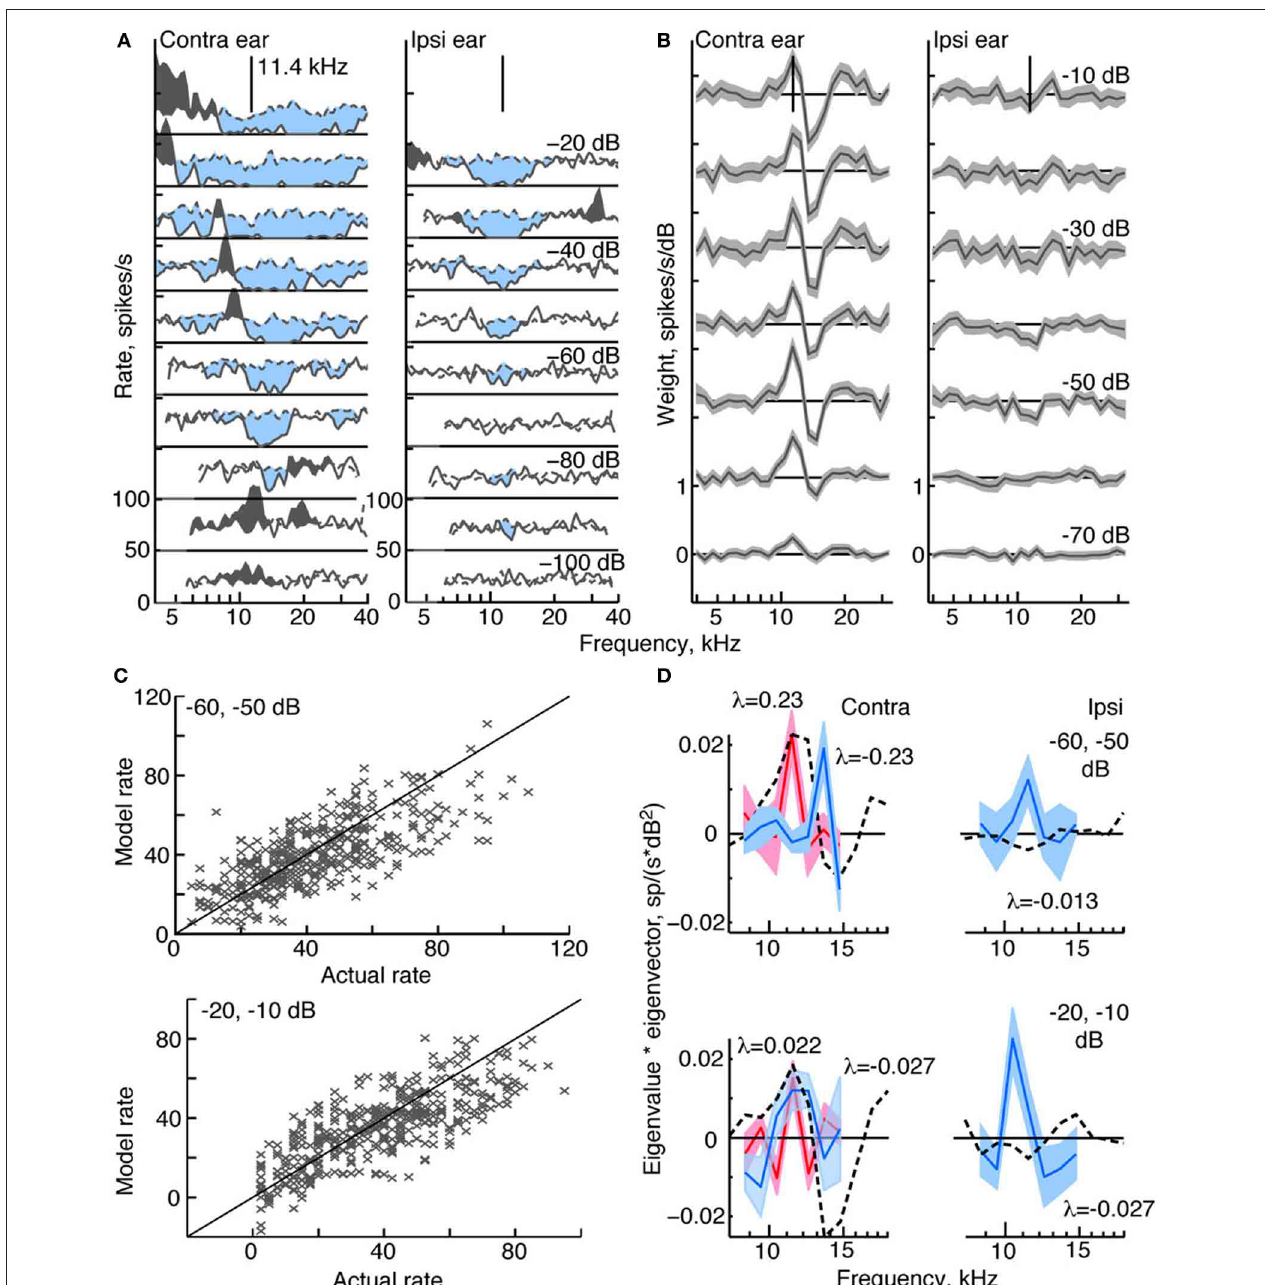
FIGURE 3 | Response characteristics for a type O neuron, BF 11.4kHz. (A,B) Tone response maps and RSS weight functions, plotted as in Figure 2 . Note the large inhibitory area centered on BF in the contralateral and ipsilateral tone response maps. Also note the difference in shape of the tone and weight-function maps. 0dB attenuation is 98dB SPL at the BF of the